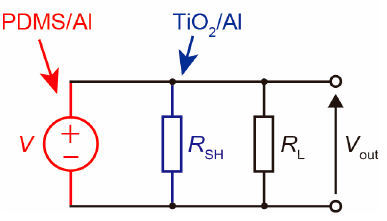
Figure 5. The equivalent circuit during triboelectric power generation.